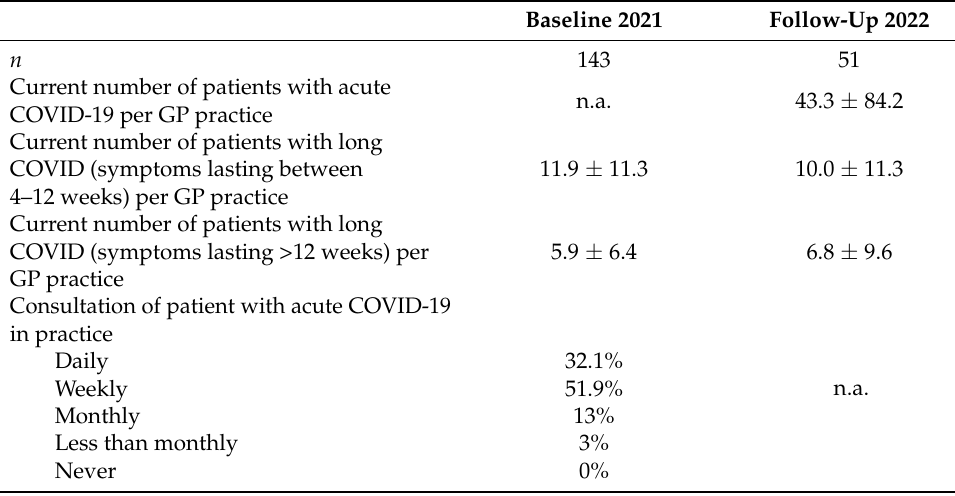
Table 3. Consultations related to COVID-19/long COVID in GP